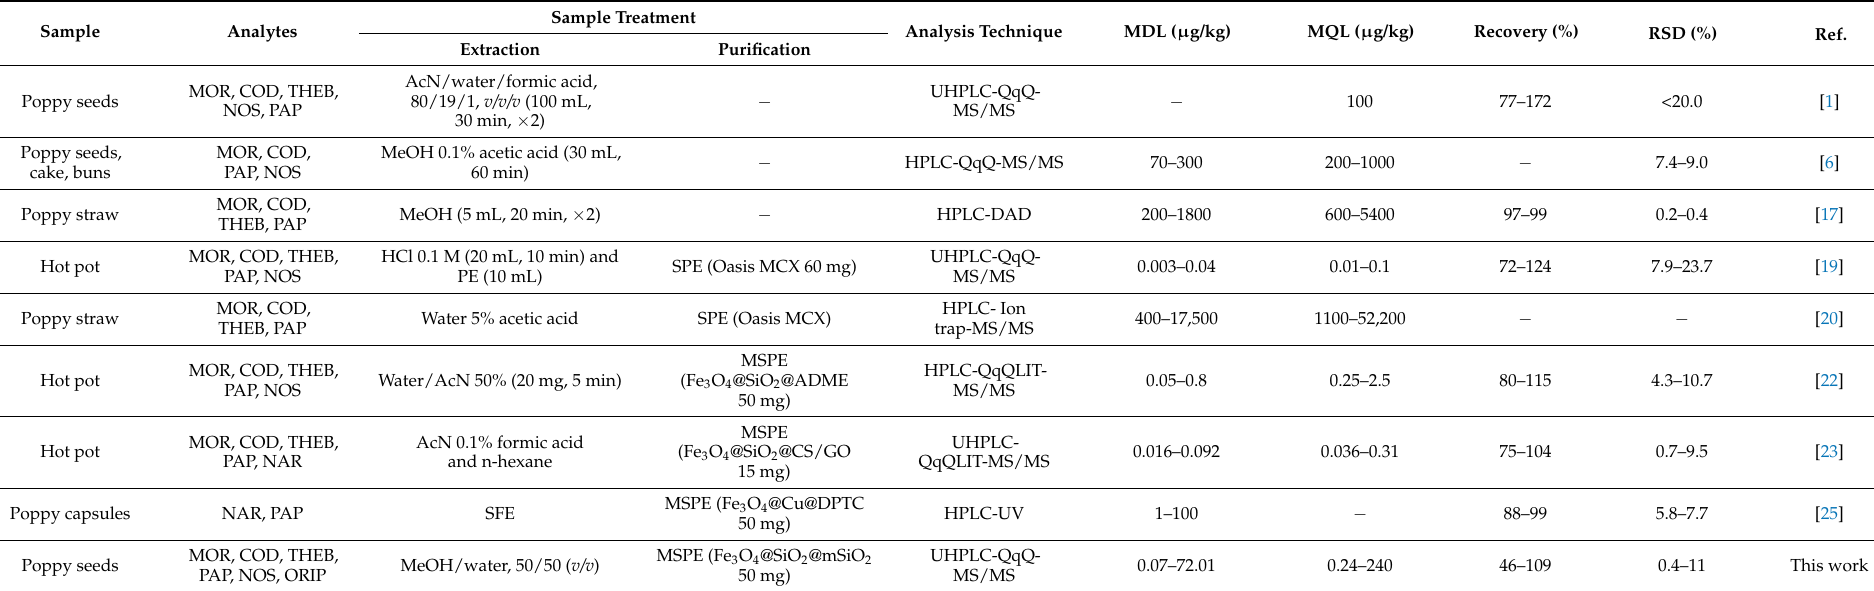
Table 3. Comparison of the developed SLE-MSPE-UHPLC-QqQ-MS/MS method with other reported methods for the detection of opium alkaloids in poppy (seeds, straw or capsules) and hot